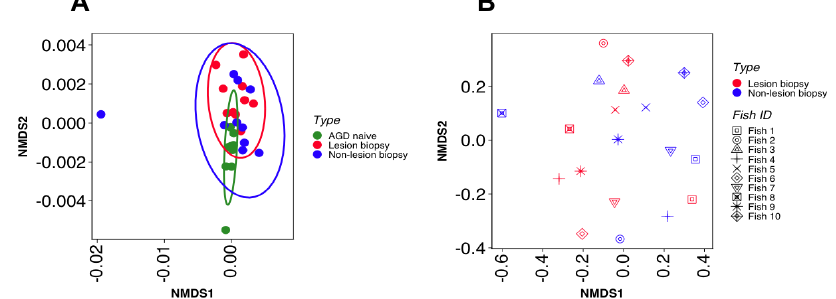
Figure 4. Beta diversity analysis using non-metric multidimensional scaling of Gower distance dissimilarity of ( A ), all sample types (stress = 0.17) and Bray Curtis ranked distance ( B ), LB and NLB samples denoting individual fish by shape (stress = 0.21). These data indicate that groupings between sample type were distinct, and that fish-to-fish variation of the LB and NLB groups was